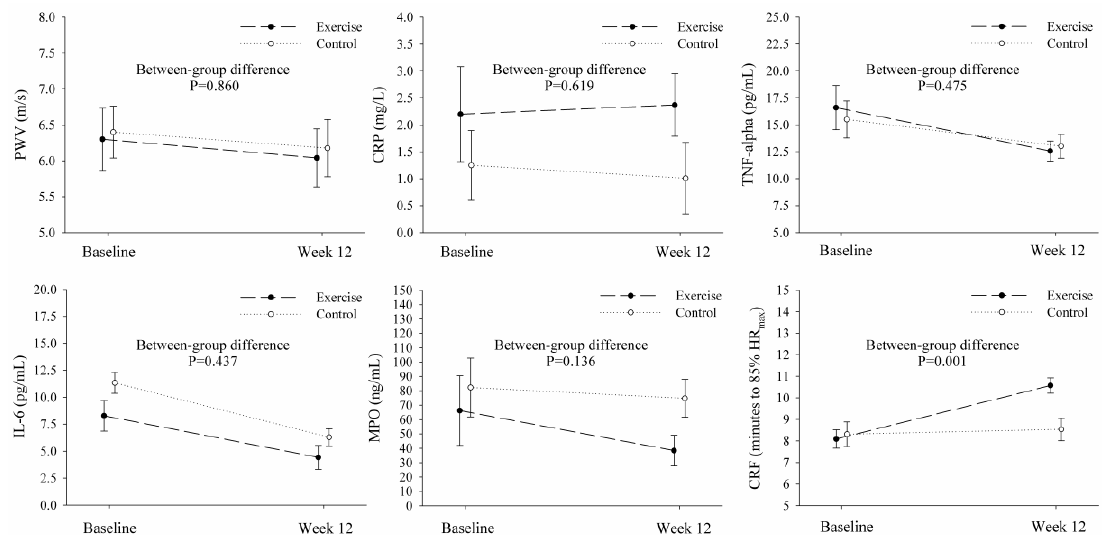
Figure 2. Graphical representation of the effects of the 12-week progressive aerobic exercise intervention. Results derived from the primary analyses (i.e., per-protocol with a minimum attendance of 75% for participants in the exercise group to be included). PWV, pulse wave velocity; hsCRP, high sensitivity C-reactive protein; TNF- α , tumor necrosis factor alpha; IL-6, interleukin-6; MPO, myeloperoxidase; CRF, cardiorespiratory fitness; HR max , maximal heart rate.